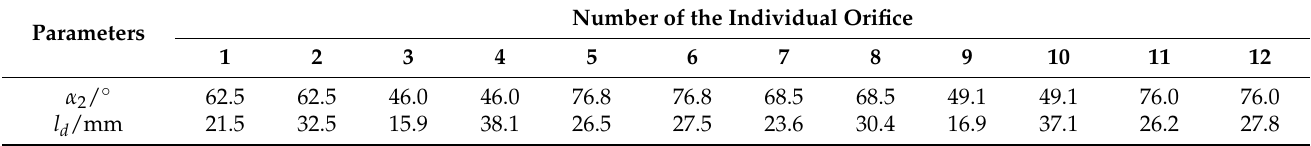
Table 4. The position of 12 individual orifices after orifice arrangement for micro-sprinkling hoses. Number of the Individual Parameters